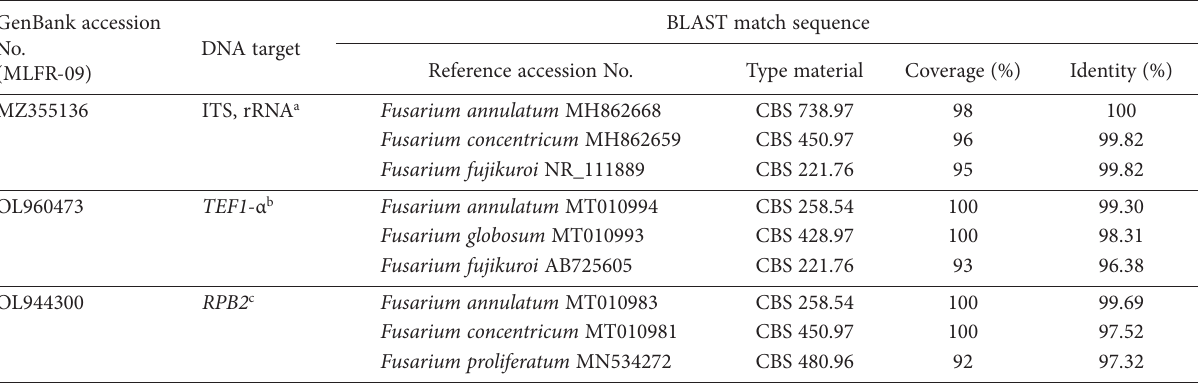
Table 1. BLAST search for gene sequences of the Fusarium annulatum isolate MLFR-09, compared with the reference sequences obtained from type culture material. GenBank accession